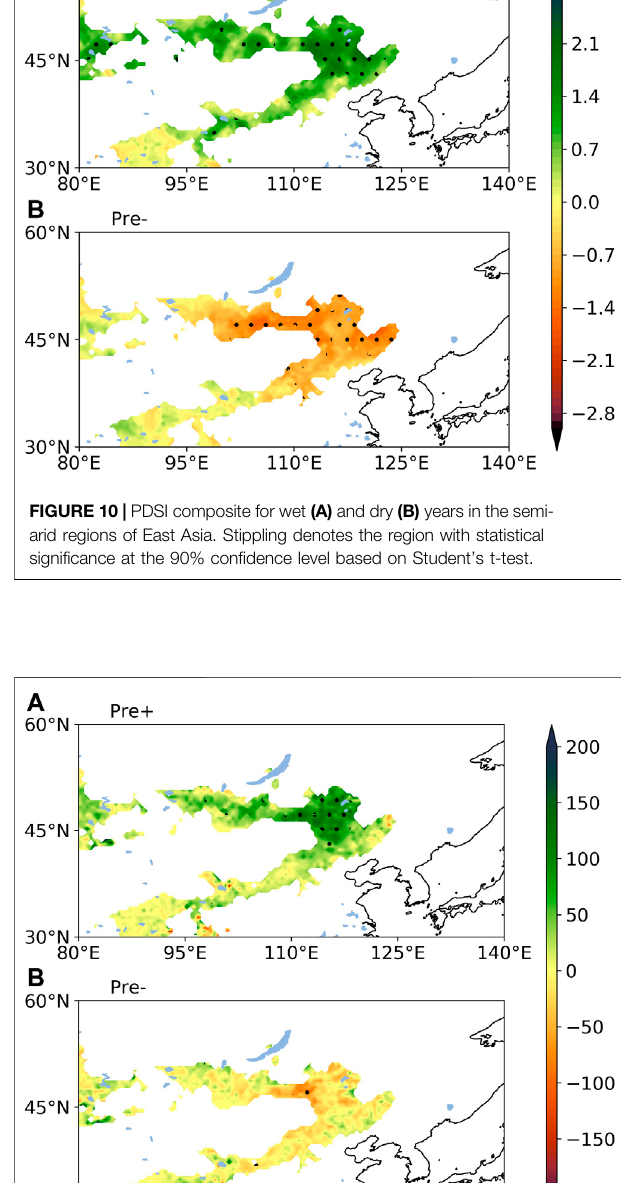
Frontiers in Earth Science |